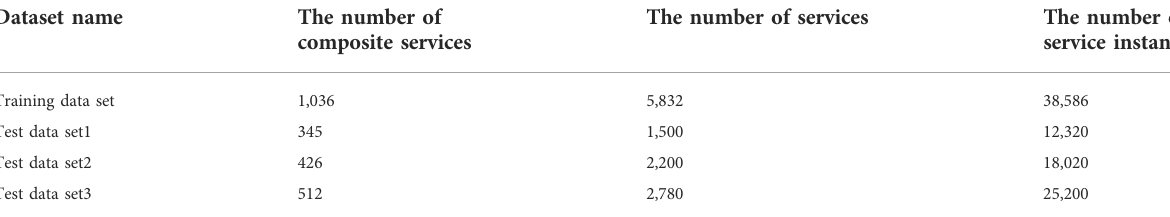
TABLE 3 Table of dataset settings.